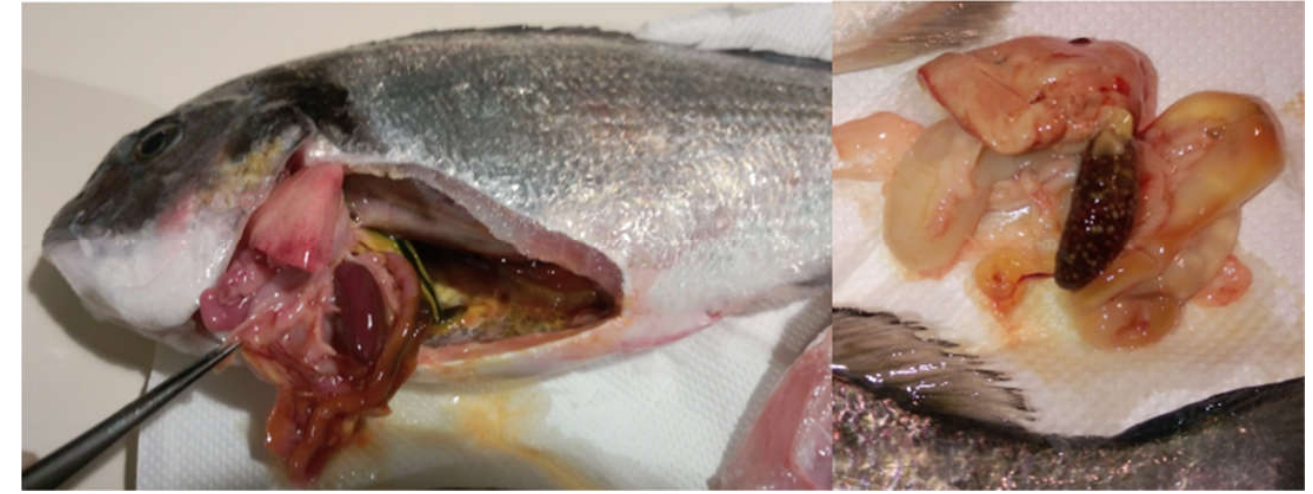
Figure 2. Splenomegaly and congestion in sea bream ( Sparus aurata ) ( left ), and whitish tubercules in the spleen of diseased sea bream ( right ).